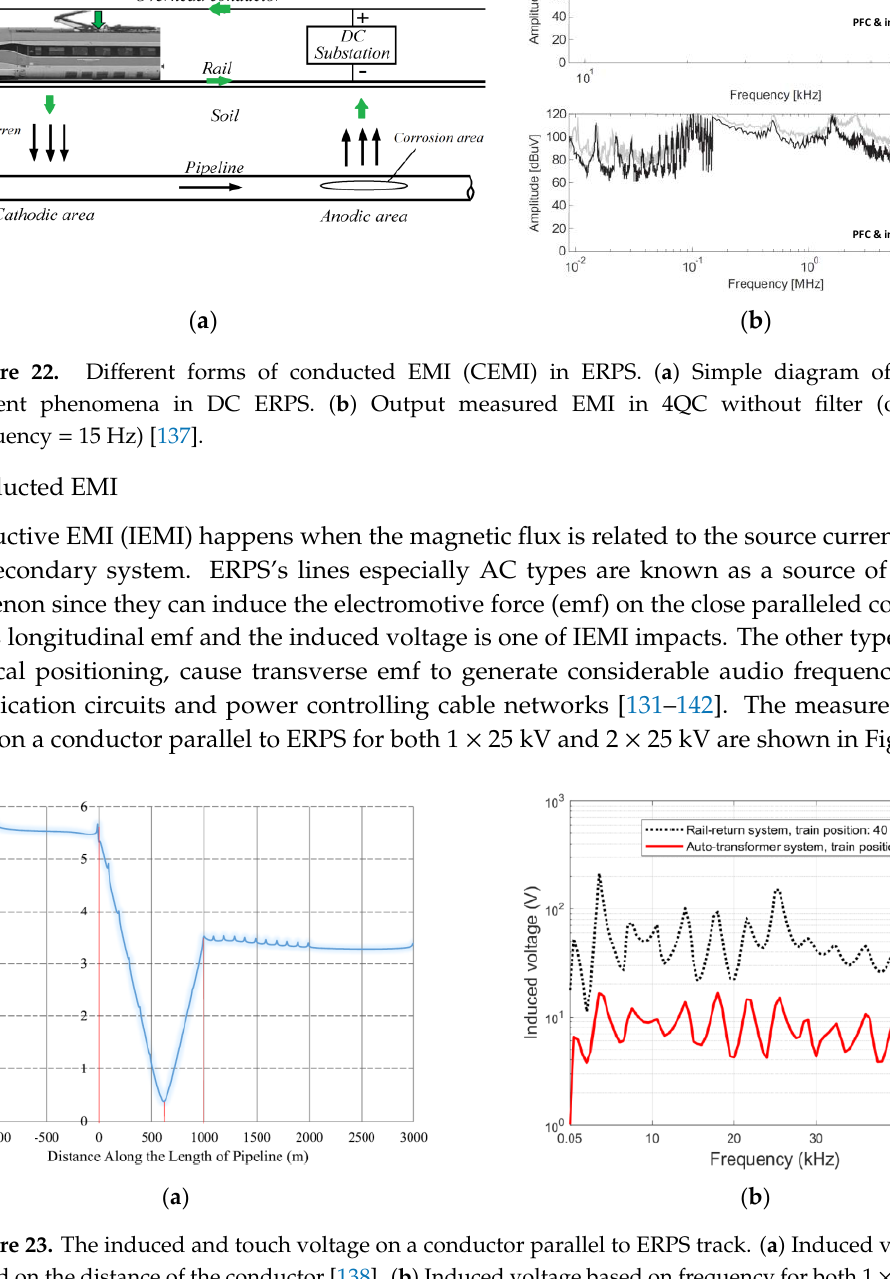
( b ) Figure 24. The static and dynamic electrostatic (EEMI) in ERPS. ( a ) Static EEMI. ( b ) Dynamic EEMI. 2.9.4. Radiated EMI One of the foremost common phenomena in ERPS especially in HSR is radiated EMI (REMI) known also as arcing. The interlinkage between the pantograph and contact wire or between the train’s brushes and the third or fourth rail in ERPS and neutral intersection points are the main